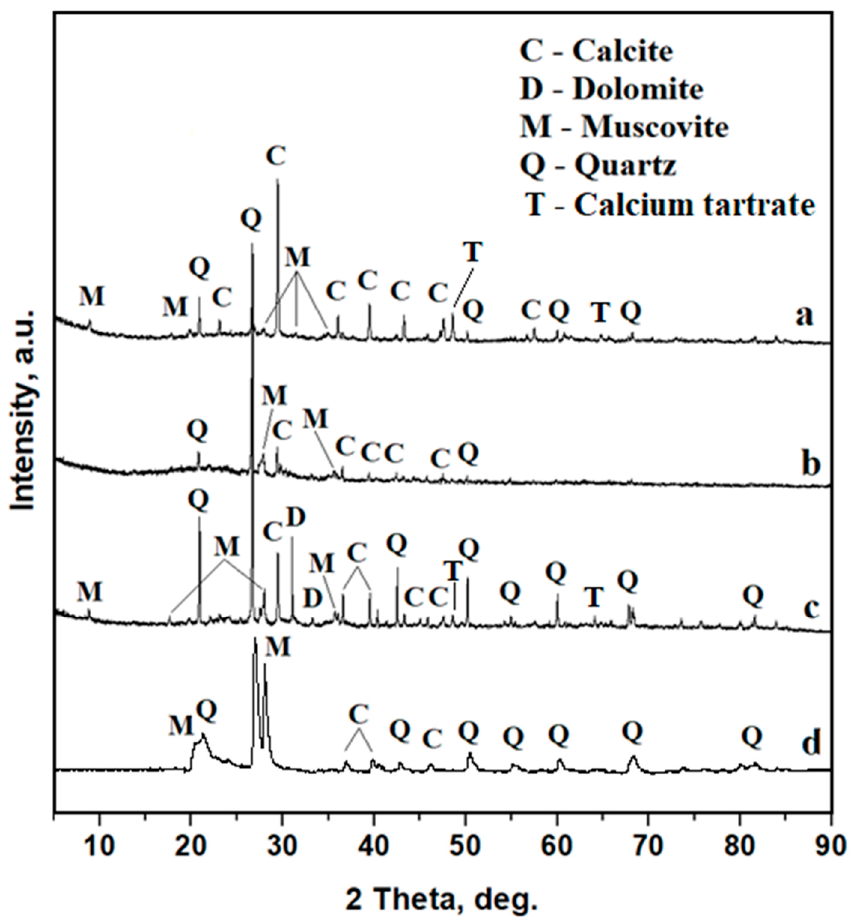
Figure 4. XRD patterns for amphora sediments: ( a ) Sample1, ( b ) Sample2, ( c ) Sample 3 and ( d ) resting soil.